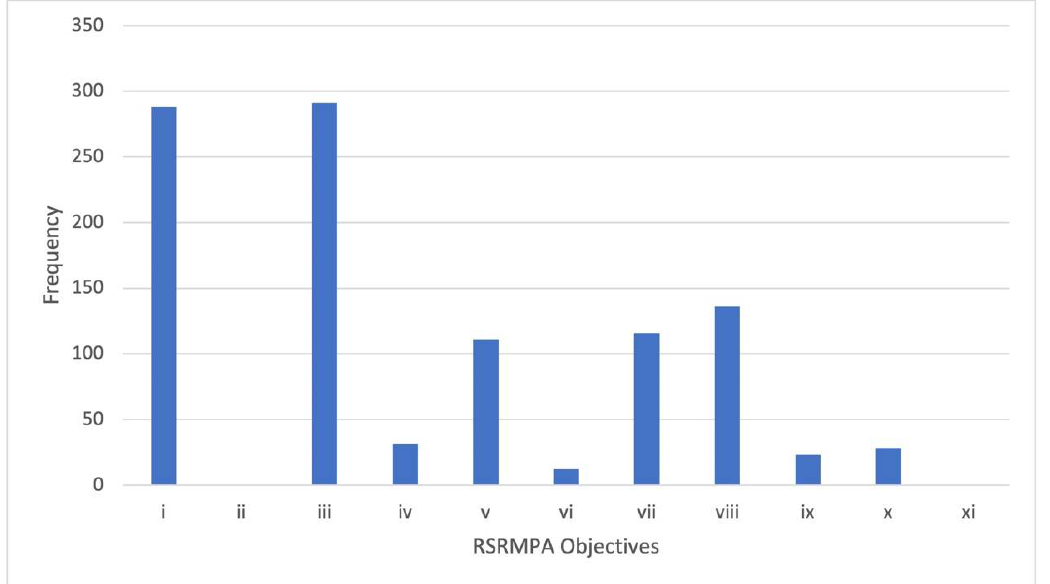
Figure 2. Frequency of peer-reviewed papers (published between 2010–April 2021; see Supplementary Material 1 for full list of papers), authored or co-authored by U.S. researchers that related to specific objectives of the Ross Sea region marine protected area (RSRMPA) (See Table 1 above for objectives).